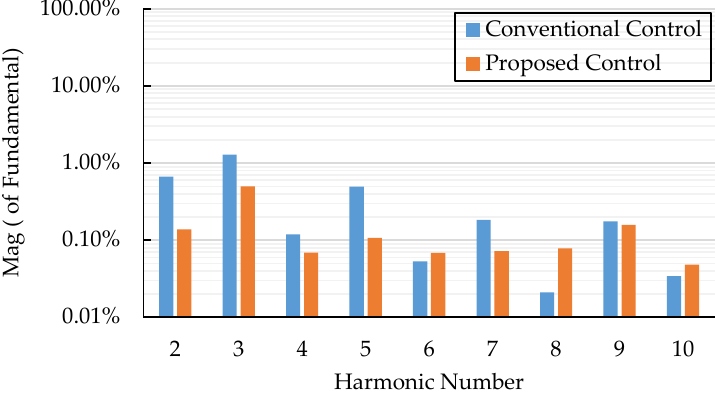
Figure 15. The magnitudes of the 2nd–10th harmonic currents of the ARSI respect to the fundamental